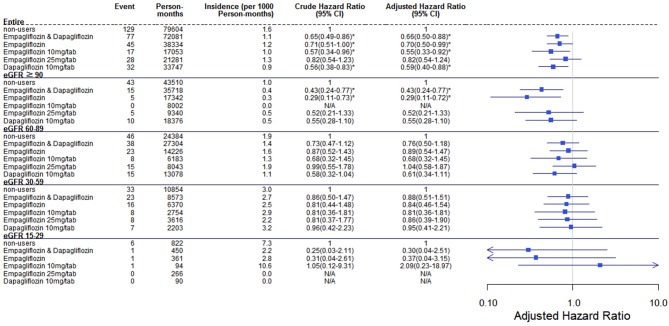
Cox proportional hazard models for AKI-related hospitalization rate in patients receiving sodium–glucose cotransporter 2 inhibitors and non-users. The probability of AKI-related hospitalization is shown for empagliflozin 10 mg/tab, empagliflozin 25 mg/tab, and dapagliflozin 10 mg/tab users vs. non-users in different renal function subgroups. AKI, acute kidney injury.